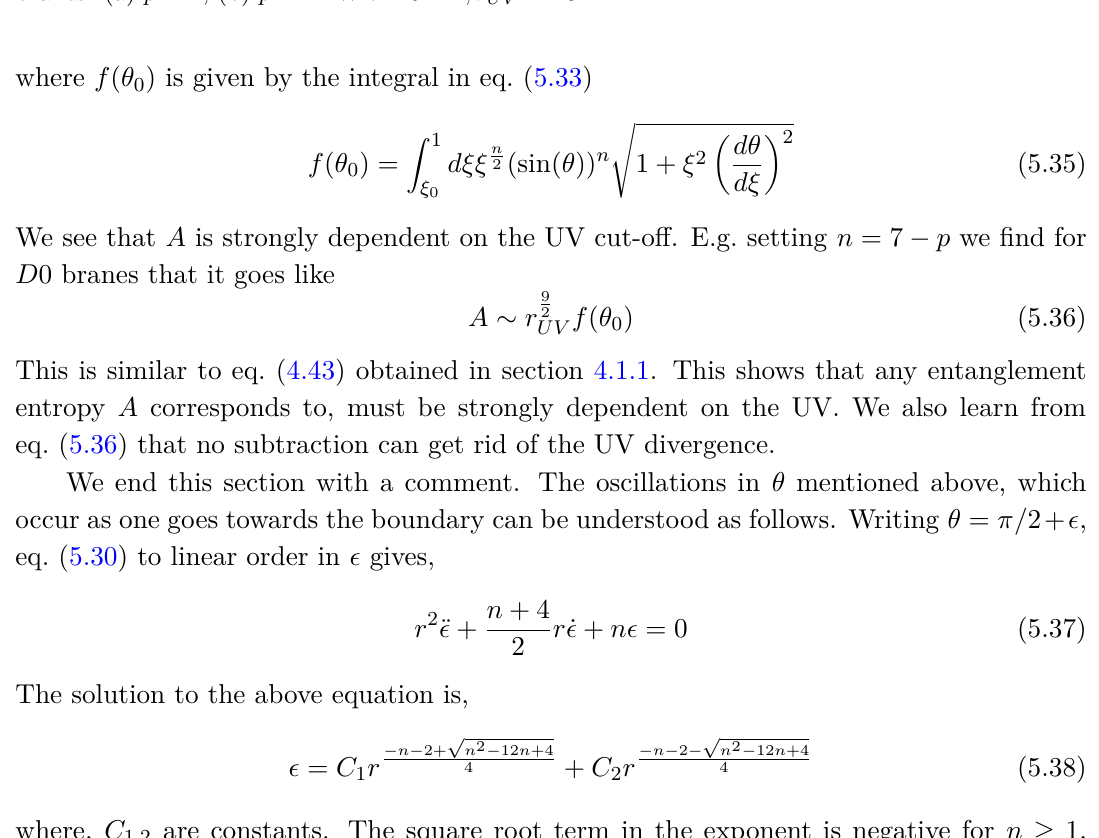
Figure 8. Plot of θ ( r ) as a function of r , for surfaces with various values of θ 0 in the case of Dp branes. (a) p = 1 , (b) p = 2 . With R = 1 , r UV = 10 4